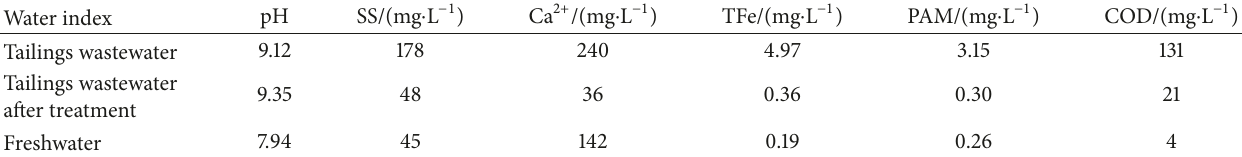
Table 4: Water quality monitoring data table.